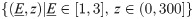
Complex dynamics of model (4).Top row: parametric portrait of the qualitative dynamics of model (4) in the domain {(E_,z)|E_∈[1,3],z∈(0,300]} at r = 1.5, w = 1.5, p = 0.1, E¯=4, ε = 0.05. White areas show the parameter regions in which only one fixed point, (5), was detected. This fixed point is an attractor. The blue region bordering the white one corresponds to the case in which fixed point (5) becomes a repeller and the second equilibrium, (6), emerges. Equilibrium (6) is locally asymptotically stable. Green areas are the domains in which an attracting periodic orbit was detected. Red and violet domains correspond to regions where complex chaotic-like dynamics were observed. Black stars, *, indicate observed co-existence of multiple attractors. Turquoise blue islands mark regions in which burst-like trajectories were observed. Inlet linked to the gray area shows theoretical estimates of transition boundaries (dashed blue and green lines) relative to the ones observed in experiments. A,B,C,D,E,F: typical dynamics observed in the corresponding parametric regions.